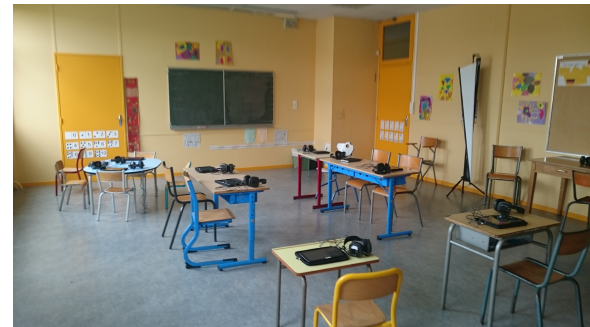
Figure 11. Experiments in class: the room adjacent to the classroom, dedicated to the use of digital tablets.